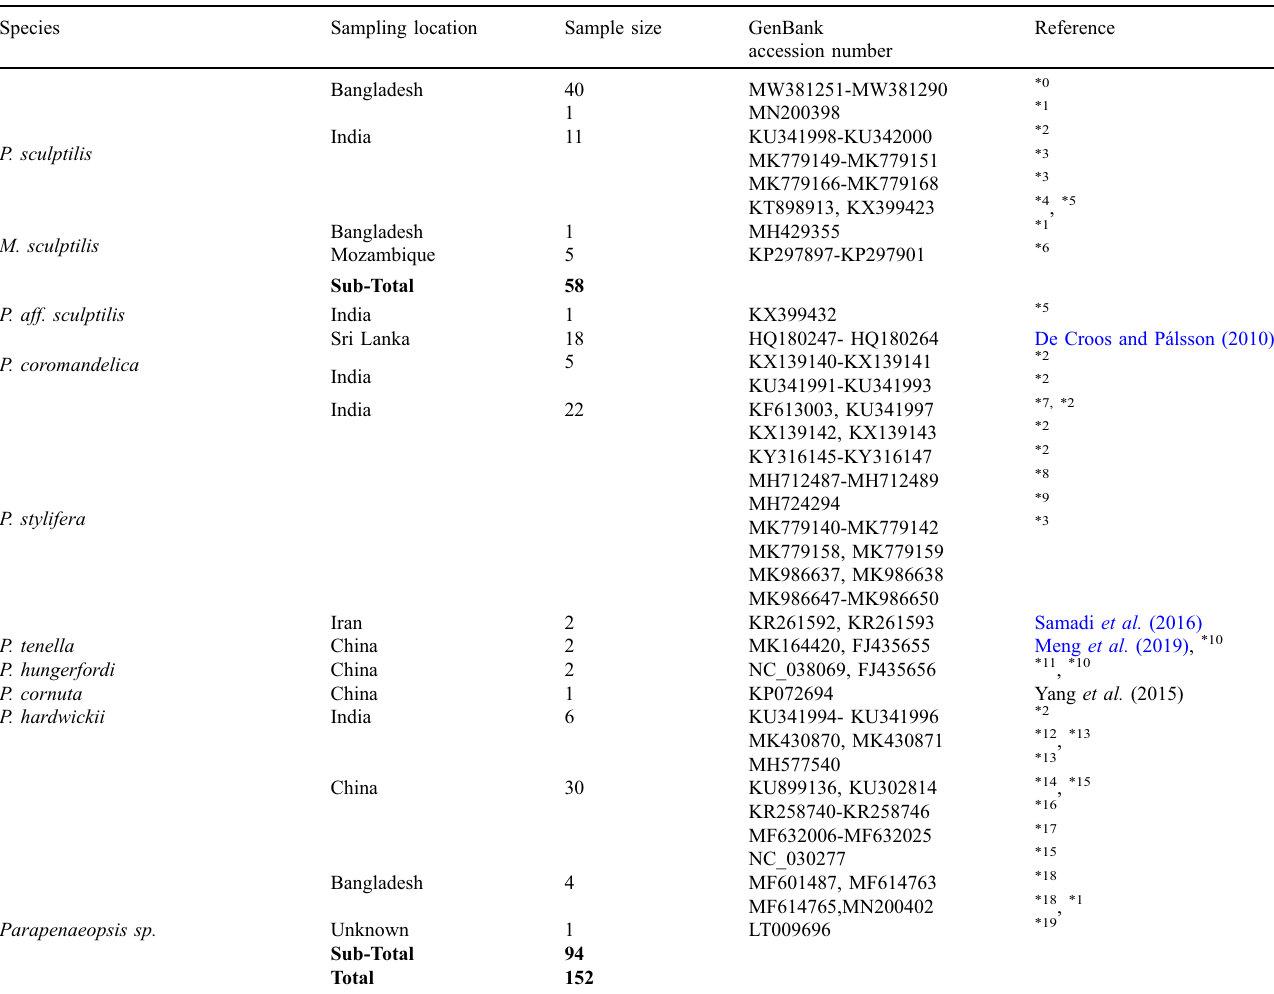
Table 1. Information about the sequences for CO1b of the mitochondrial DNA of the genus Parapenaeopsis utilized for the study.